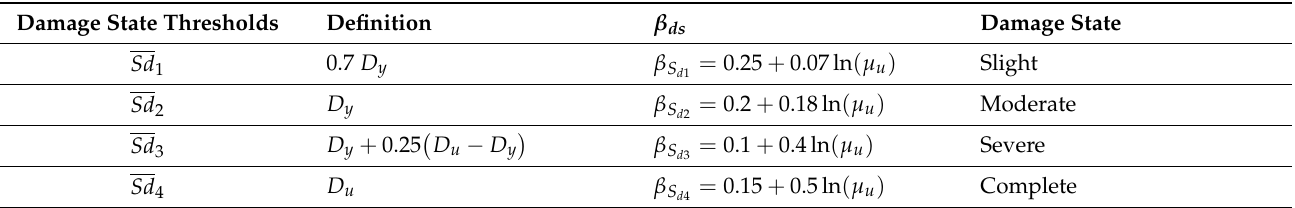
Table 1. Damage state